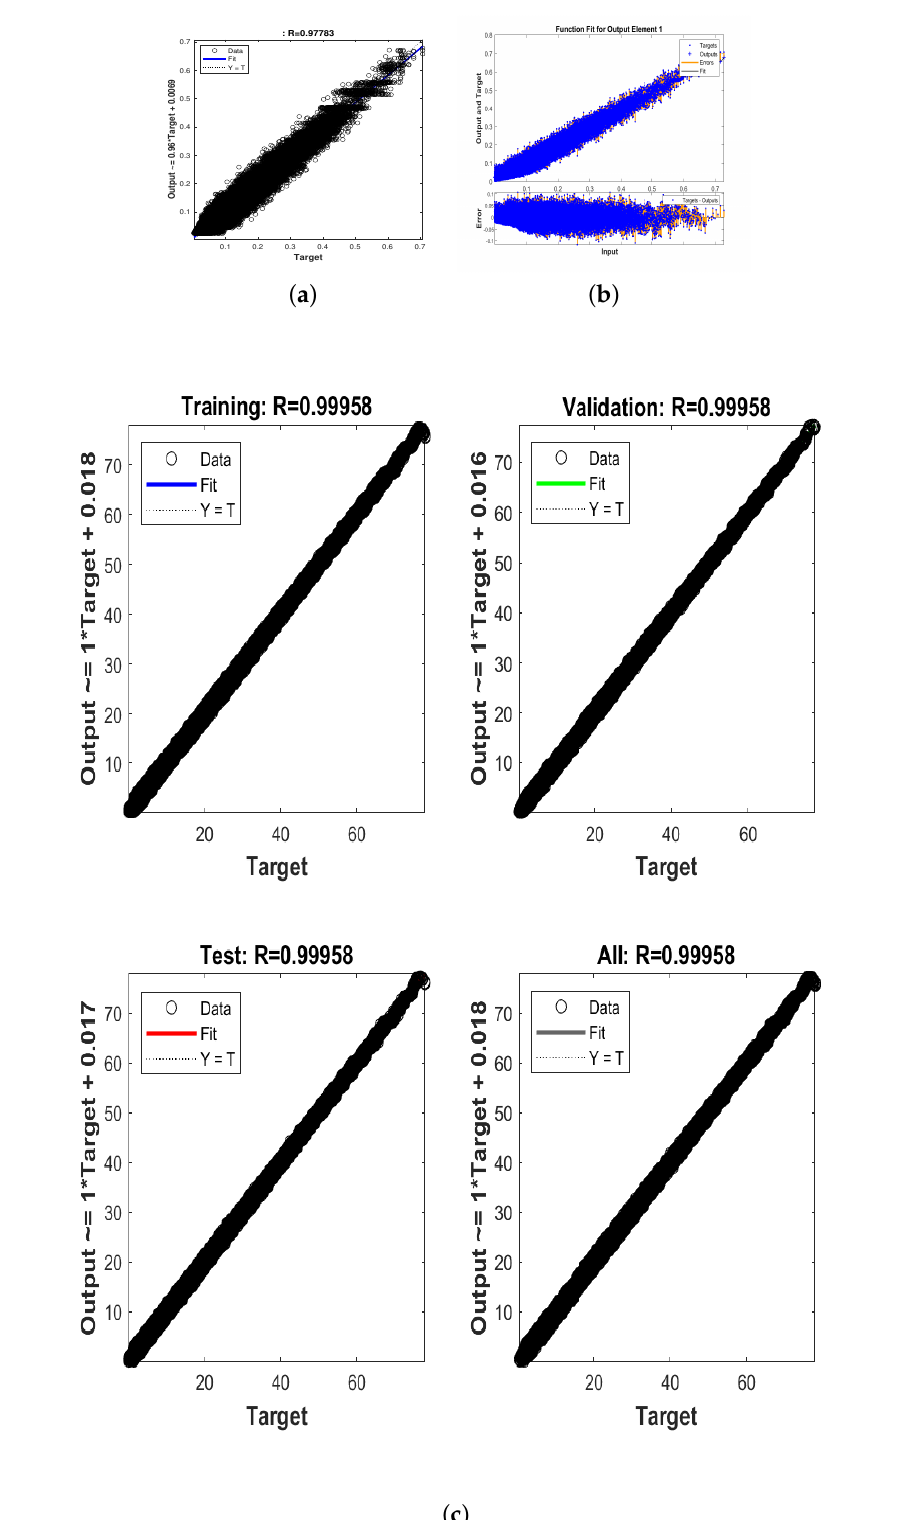
Figure 10. ( a ) Figure showing the regression fit for the data. ( b ) Figure showing the regression fit and error estimates of the fit. ( c ) Figure showing regression fit for training, testing, validation and overall